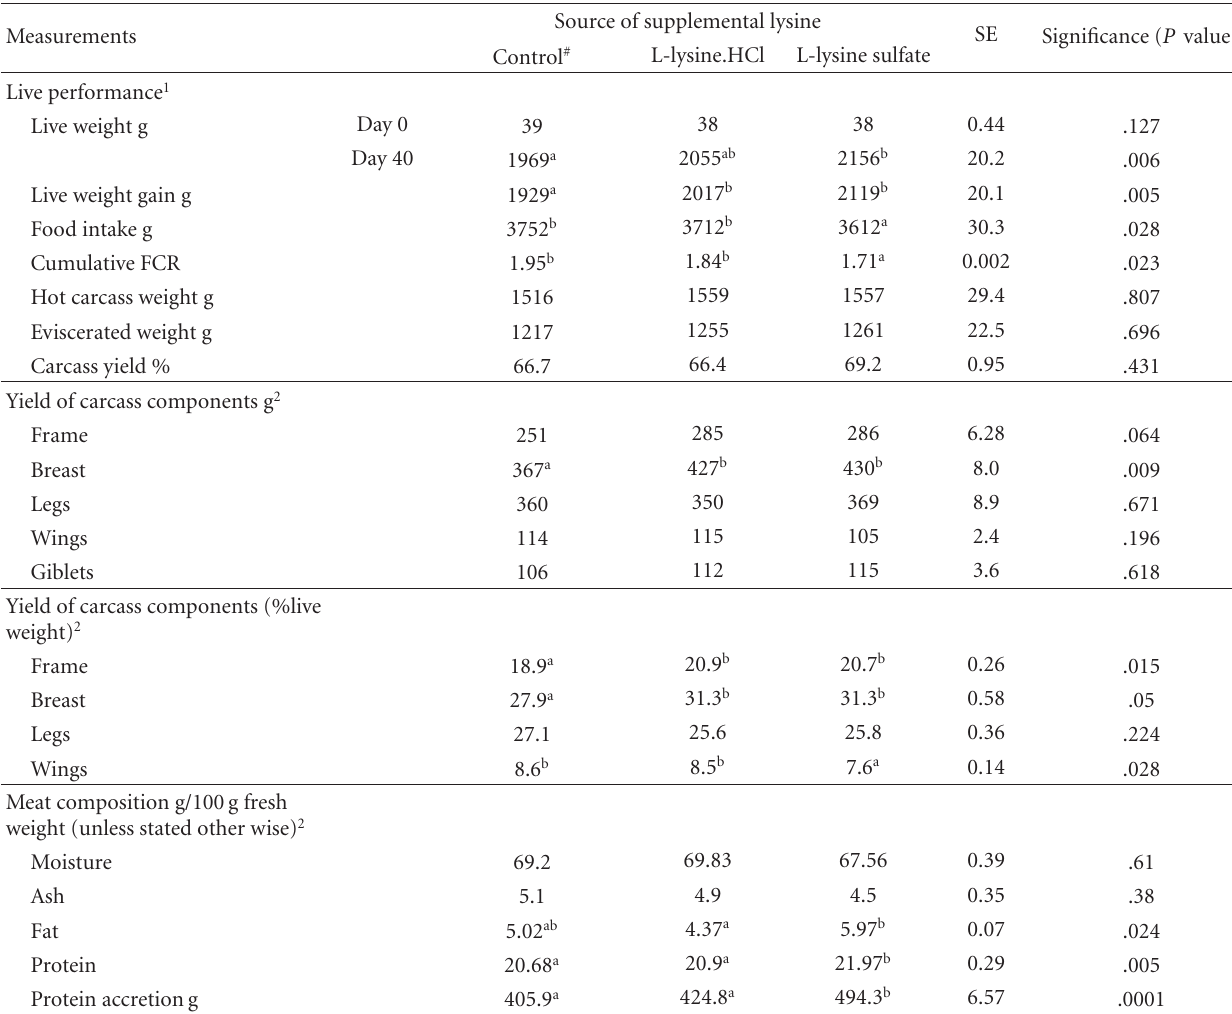
Table 3: Carcass traits and meat composition of broiler chickens fed diets supplemented with L-lysine.HCl and L-lysine sulfate.